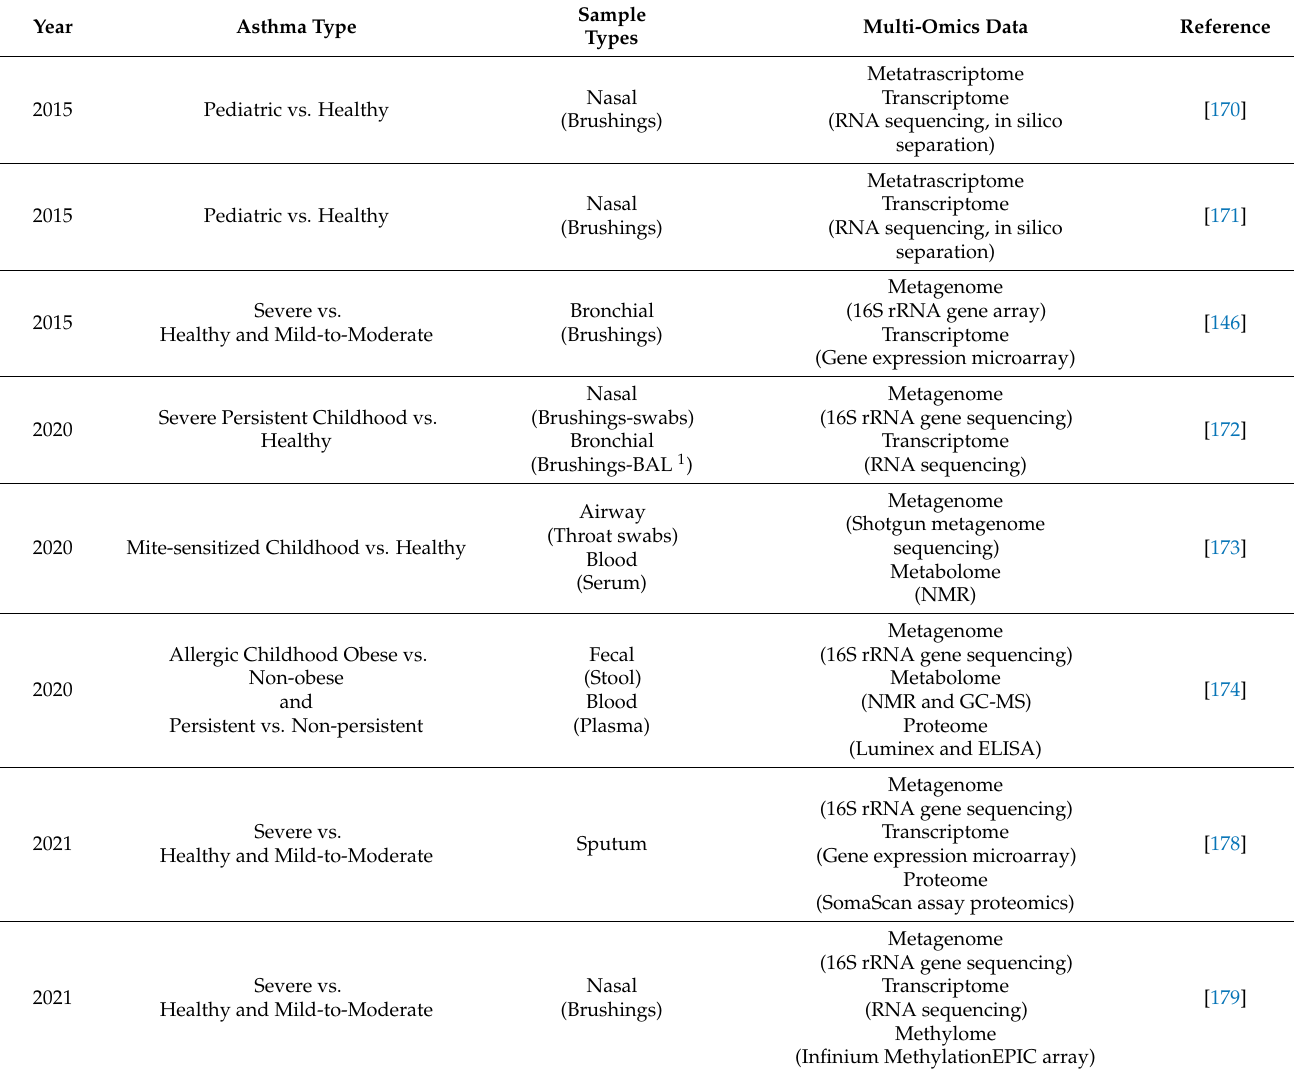
Table 2. List of multi-omics integration studies in